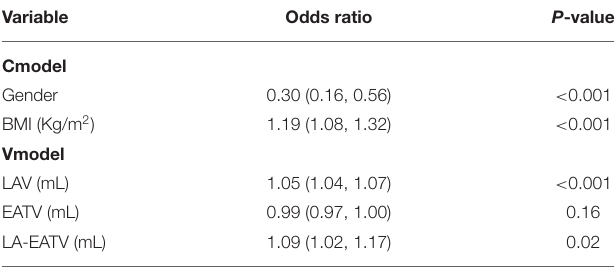
TABLE 4 | Risk factors for AF subtype.